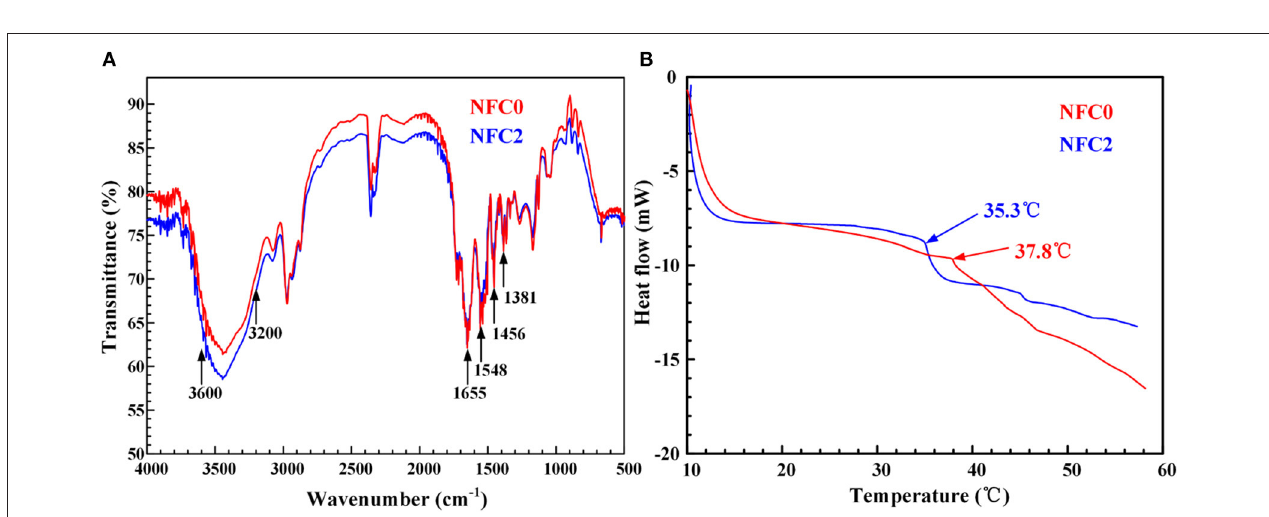
FIGURE 5 | Distribution characteristics of Young’s modulus of the (a) NFC0 and (b) NFC2 intelligent hydrogels.